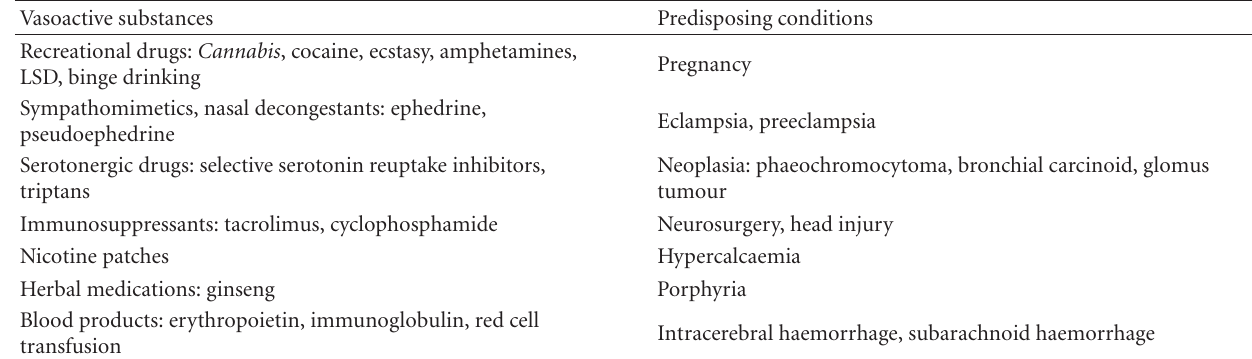
Table 2: Secondary precipitants of RCVS